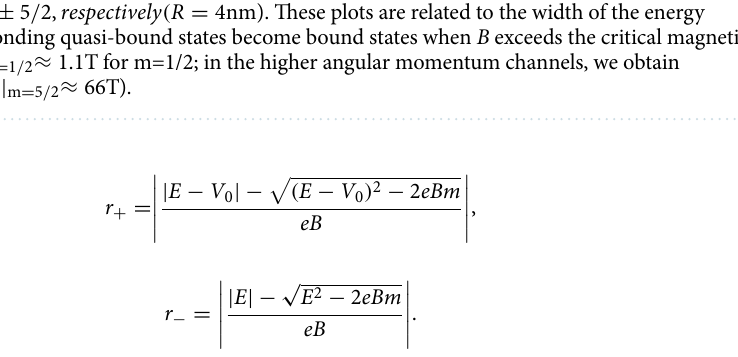
Panels (b), (c), and (d) of Fig. 2 plot the dependences of r 4nm . with R = The wavefunction in the classical allowed region II then follows from Eqs. (15) and (16):